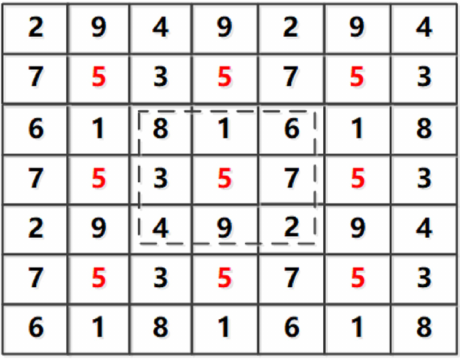
Figure 12. 7 × 7-scale nested magic square